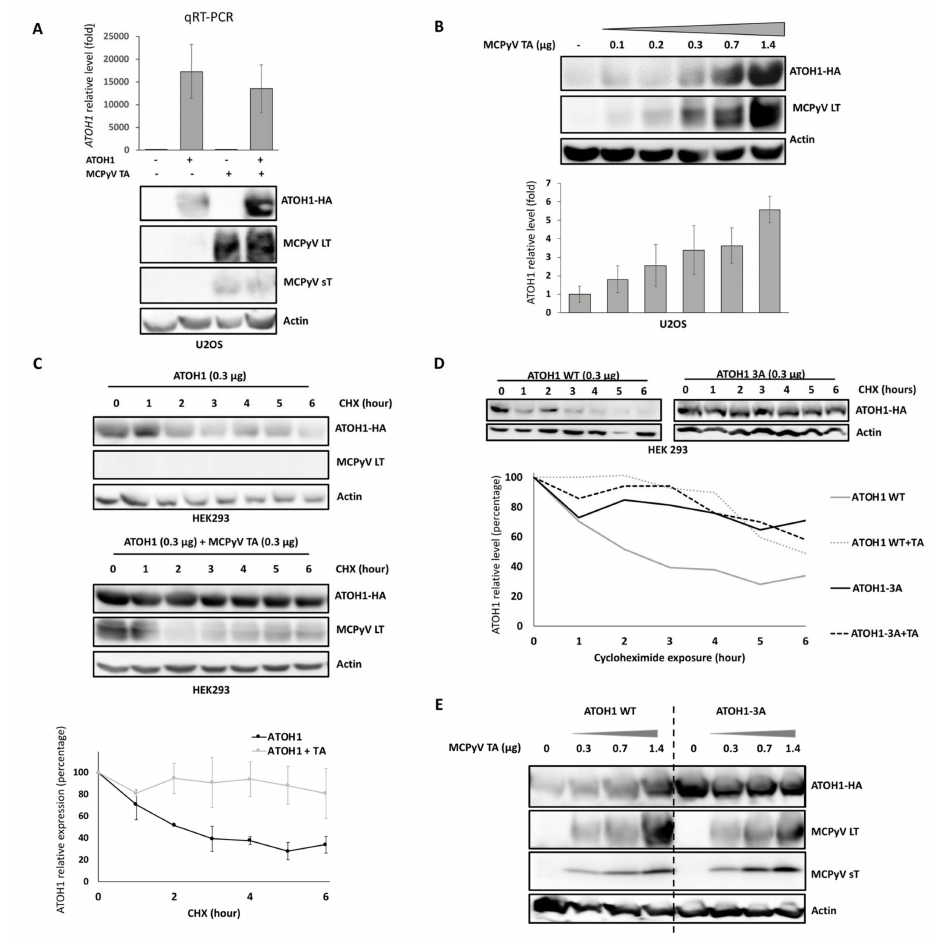
Figure 5. MCPyV T antigens increase the half-life of ATOH1 ( A ) Hemagglutinin (HA)-tagged ATOH1- and / or TA-encoding plasmids were transfected either individually or combined into U2OS cells. After two days, real-time PCR and immunoblot analyses were performed. While ATOH1 mRNA was not a ff ected (mean ± SEM of three independent experiments), ATOH1 protein accumulation in the presence of TA was observed. ( B ) Co-transfection of a constant amount (0.3 µ g) of HA-tagged ATOH1 and increasing amounts of TA in U2OS cells followed by immunoblot analysis. ATOH1-HA signals relative to actin were quantified using ImageJ. Mean ± SEM of three independent experiments was displayed. ( C ) Evaluation of ATOH1 half-life in absence or presence of T antigens. Twenty-four hours after transfection, HEK293 cells were exposed to the translation inhibitor cycloheximide (CHX) for variable durations (0–6 h). ATOH1-HA expression was then evaluated by immunoblot analysis and quantified using the Image J Software (mean ± SEM of three independent experiments are depicted). ( D ) A mutant of ATOH1-HA, in which the three serines at positions 331, 337, and 342 were all exchanged to alanines (ATOH1-HA-3A), was generated, and the impact of co-transfected TA on ATOH1-HA wild type and ATOH1-HA-3A expression was analyzed in CHX chase experiments (see C). Quantified signals relative to actin are given in the graphs below. ( E ) Co-transfection of ATOH1-HA-3A with increasing amounts of TA did not a ff ect ATOH1 protein expression level (this was confirmed in a second independent experiment). Uncropped membranes and Western blot signal quantifications are available in Figures S8 and S9,